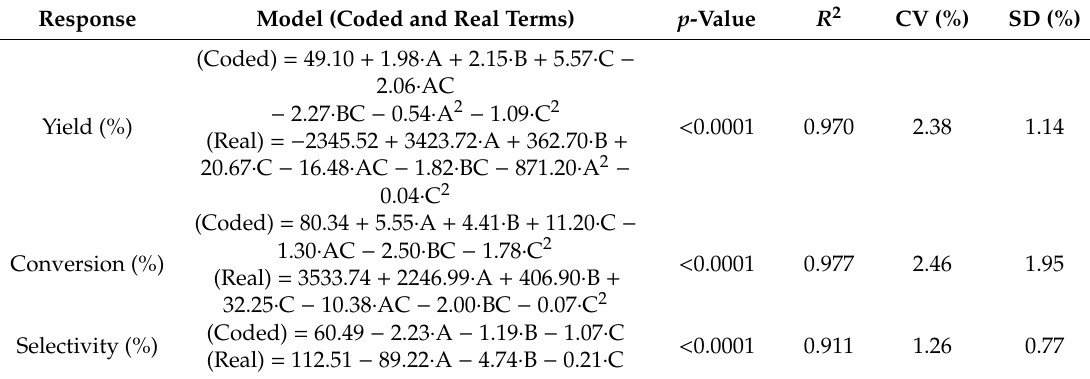
Table 4. Models in coded and real terms obtained for performance, conversion, and selectivity in the rotatable composite central design. A = concentration of FeCl 3 , B = time, and C =